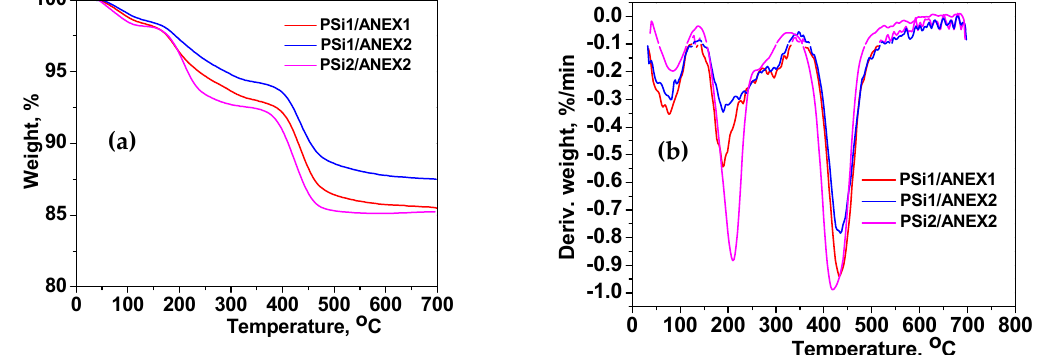
Figure 2. TG ( a ) and DTG ( b ) curves of the PSi / ANEX composite sorbents.